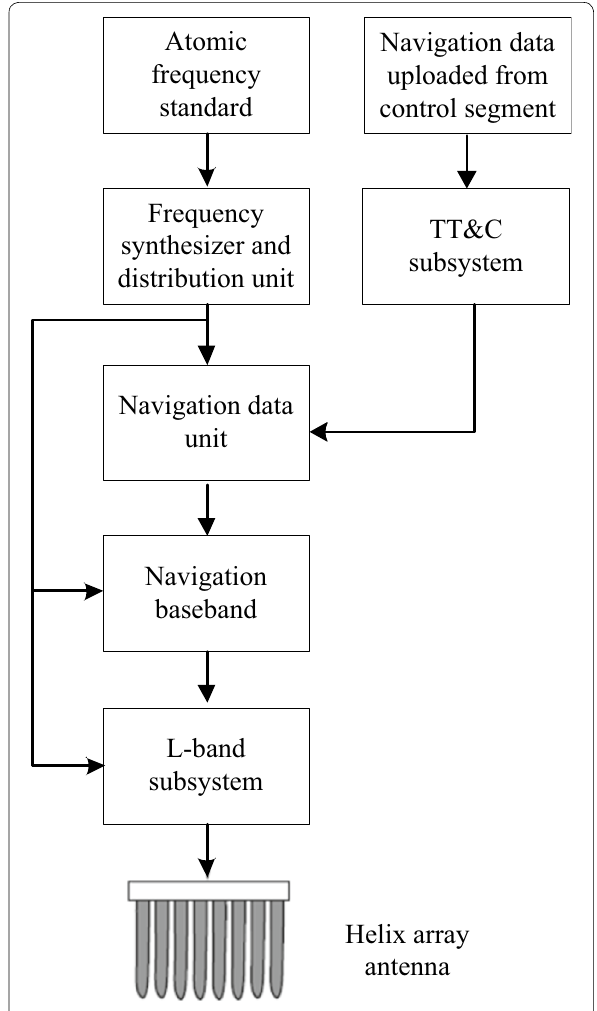
Fig. 10 Design of the BDSBAS GEO